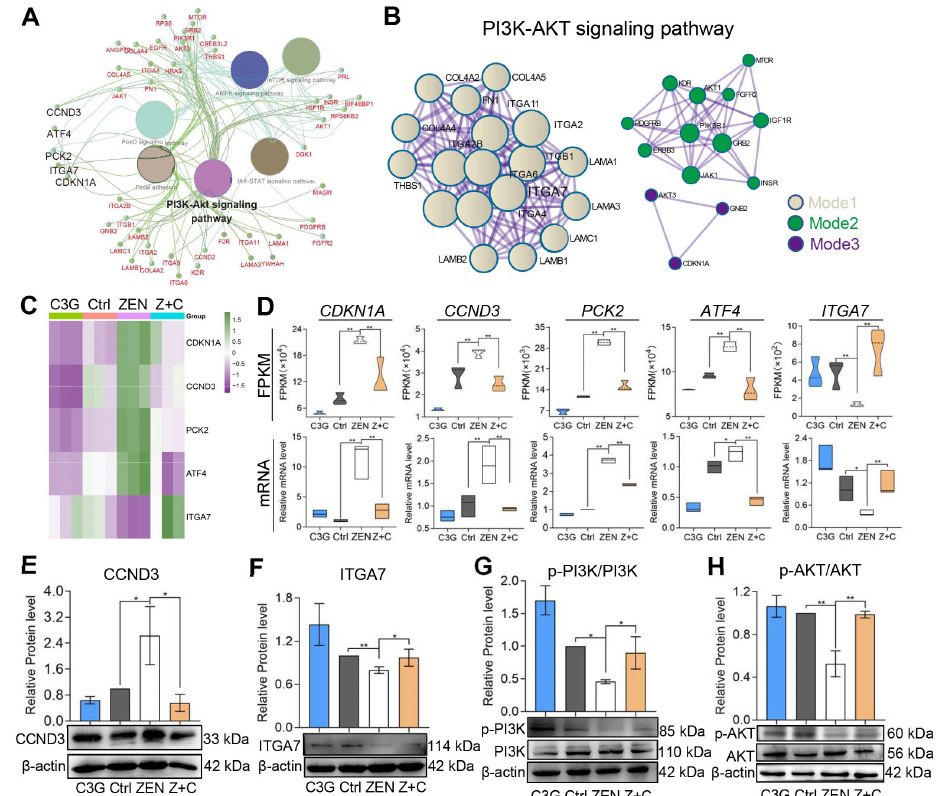
Figure 4. Expression analysis of key genes in the PI3K-AKT signaling pathway. ( A ) The results of KEGG pathway of the PI3K-AKT-related DEGs by ClueGO. ( B ) PPI network of the PI3K-AKT-related DEGs visualized by Cytoscape. ( C ) Heatmap of key genes in the PI3K-AKT signaling pathway. ( D ) The FPKM values and relative mRNA levels of DEGs CDKN1A , CCND3 , PCK2 , ATF4 , and ITGA7 . ( E – H ) WB showing the relative protein levels of CCND3 (( E ), β -actin as the internal reference), ITGA7 (( F ), β -actin as the internal reference), PI3K, and phospo-PI3K (p-PI3K) ( G ) AKT and p-AKT ( H ), respectively. All data were quantified as mean ± SEM; n = 3. All experiments were repeated at least 3 times. * p < 0.05, ** p < 0.01.